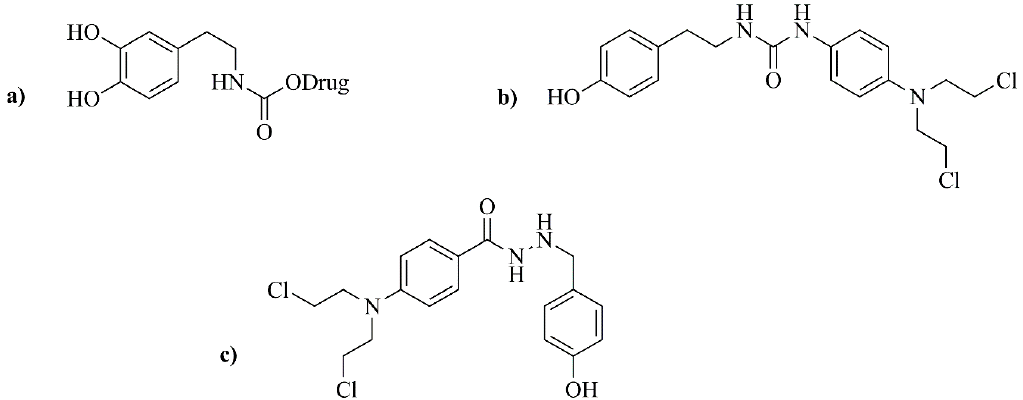
Figure 4. Examples of first-generation prodrugs. ( a ) Prodrug with a dopamine moiety and a carbamate linkage; ( b ) Prodrug with urea-linked aniline mustard; ( c ) Concept of a prodrug displaying a phenolic activator, a hydrazine linker and a nitrogen mustard effector.